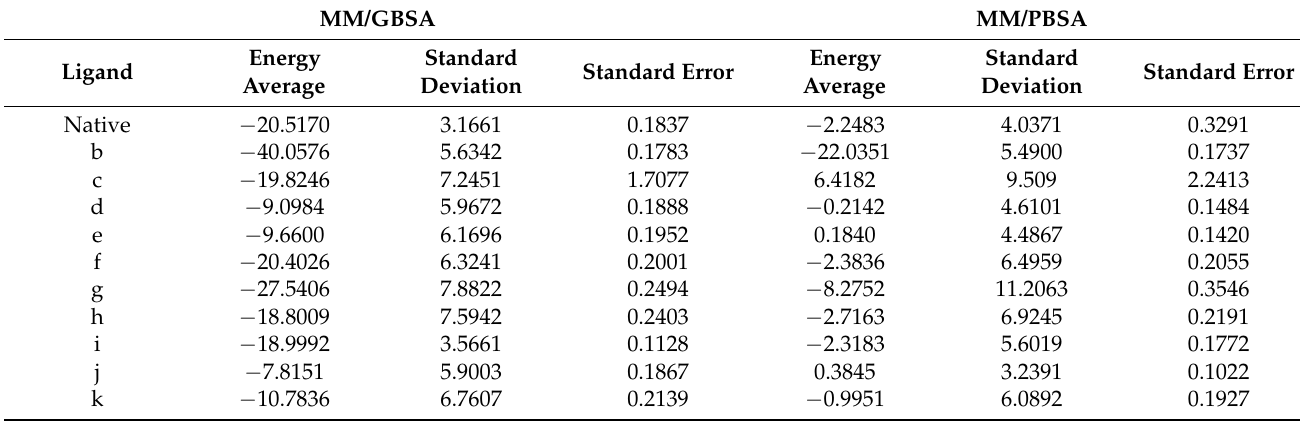
Table 5. Free binding energy to the 4XO9 protein calculated using MM/GBSA and MM/PBSA methods.